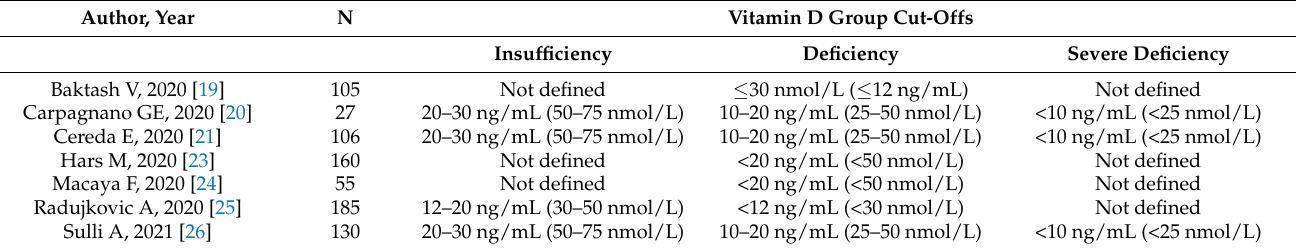
Table A1. Cut-offs used to define vitamin D groups in the six studies on vitamin d deficiency included in the present